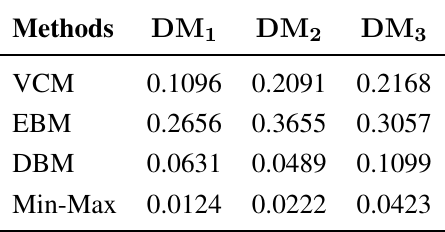
Table 1. Uniformity of the criteria’s